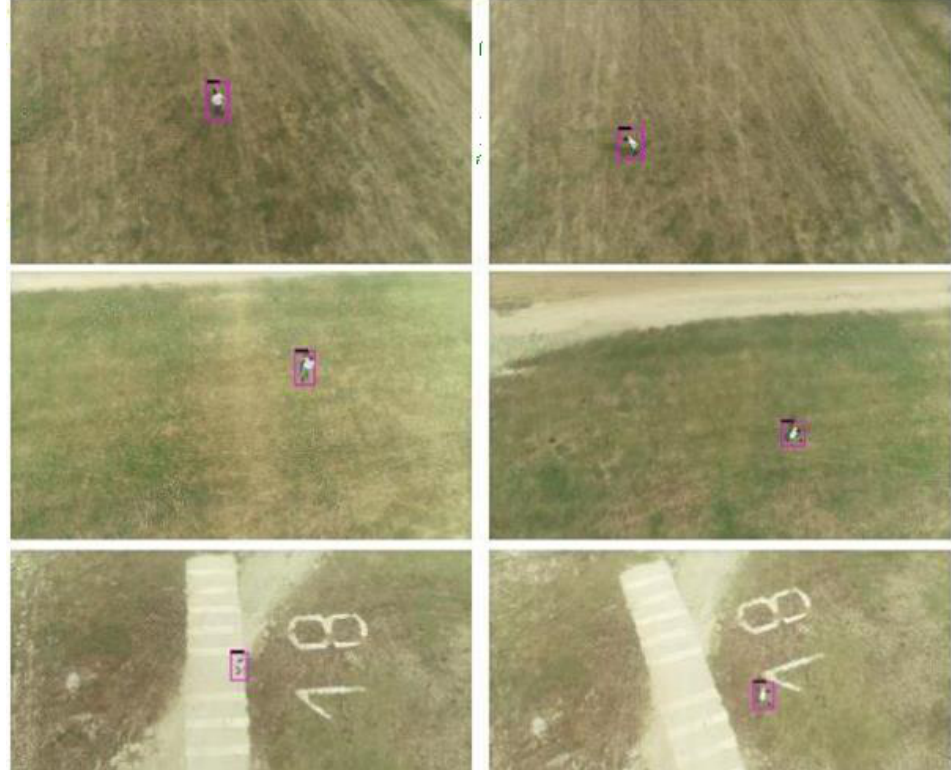
Figure 33. Inference results sequence for one person.